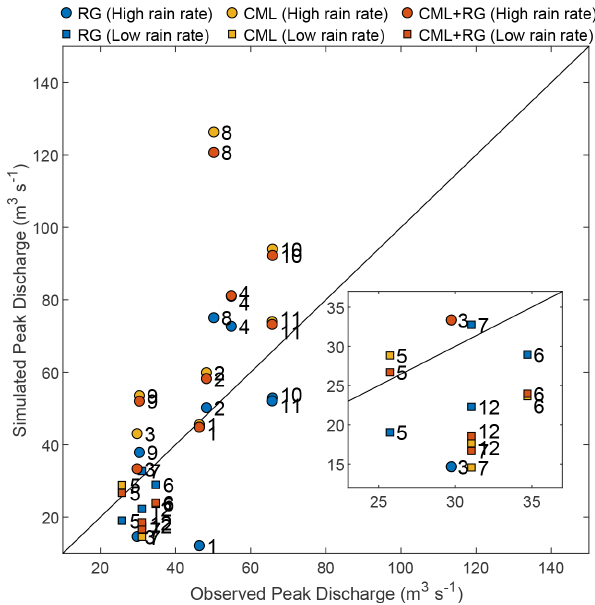
Figure 11. Observed peak flow against that simulated from RG (blue), CML (yellow), and CML+RG (orange) data. The two dif- ferent markers represent high-rain-rate (circles) and low-rain-rate (squares) events. The inset presents a zoomed in view of events with a low peak